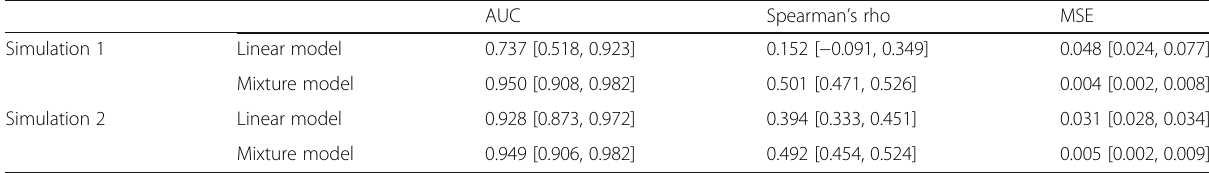
Table 3 Results of the two simulation studies given as mean (0.05 quantile, 0.95